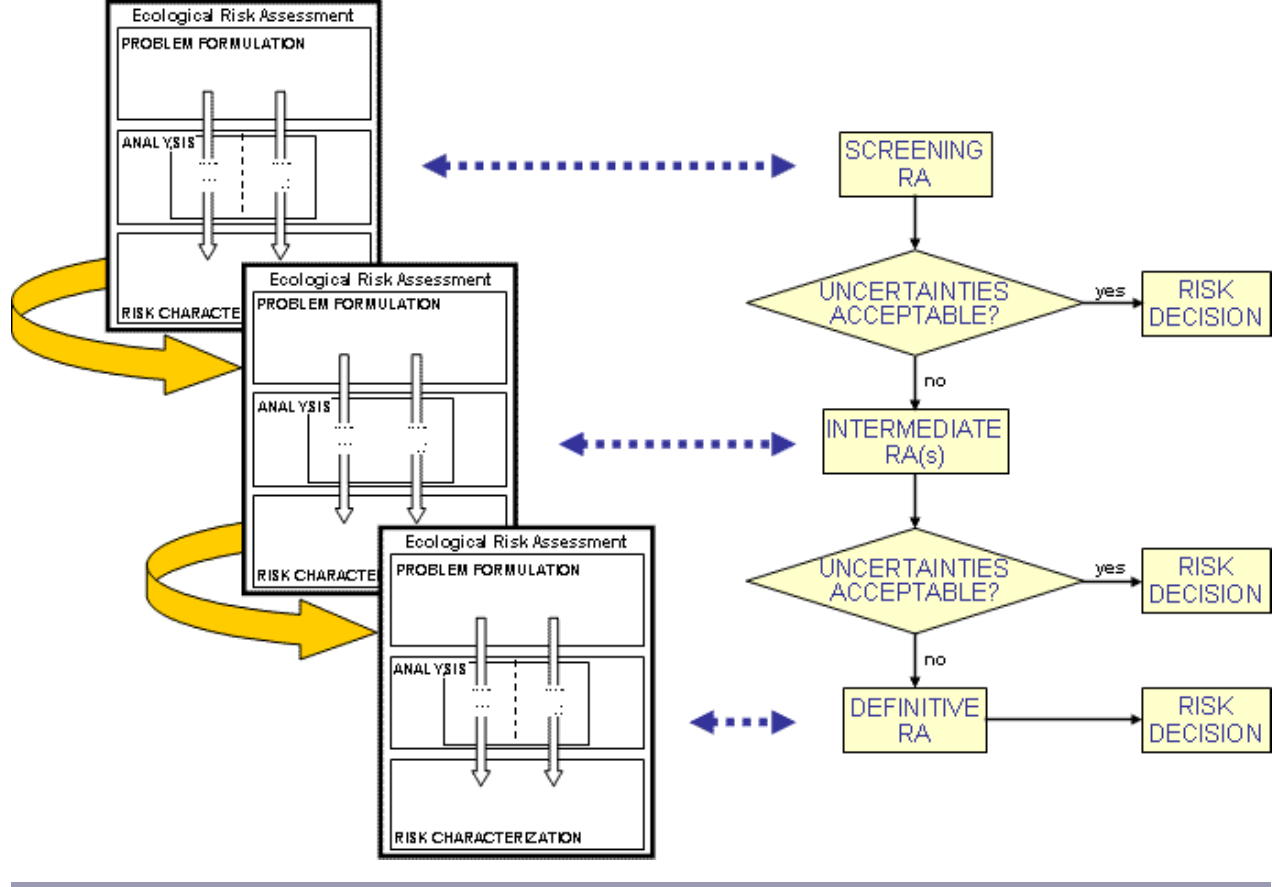
Fig. 3. Tiering of wildlife risk assessment, on the left showing iterations of the U.S. EPA (1992, 1998) process of ecological risk assessment, and on the right, the decision process for moving through the